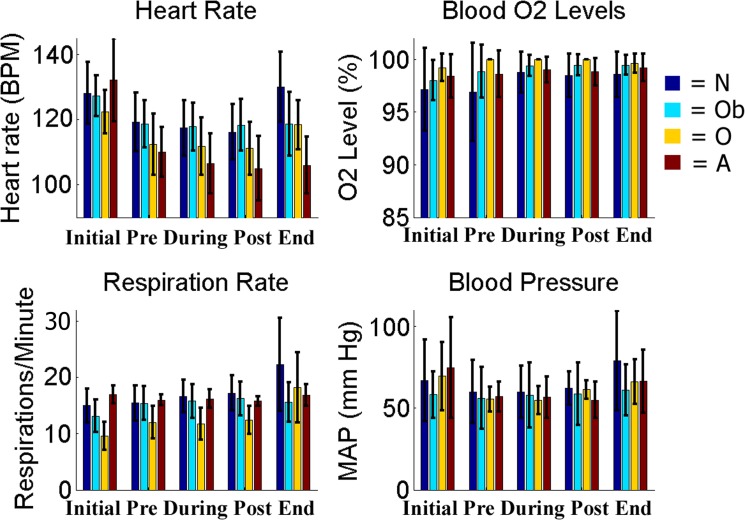
Vital Monitoring.Vitals collected at five points throughout the duration of the FUS with MB procedure. Results in the grey shaded region indicate time-points acquired during the FUS proceure.